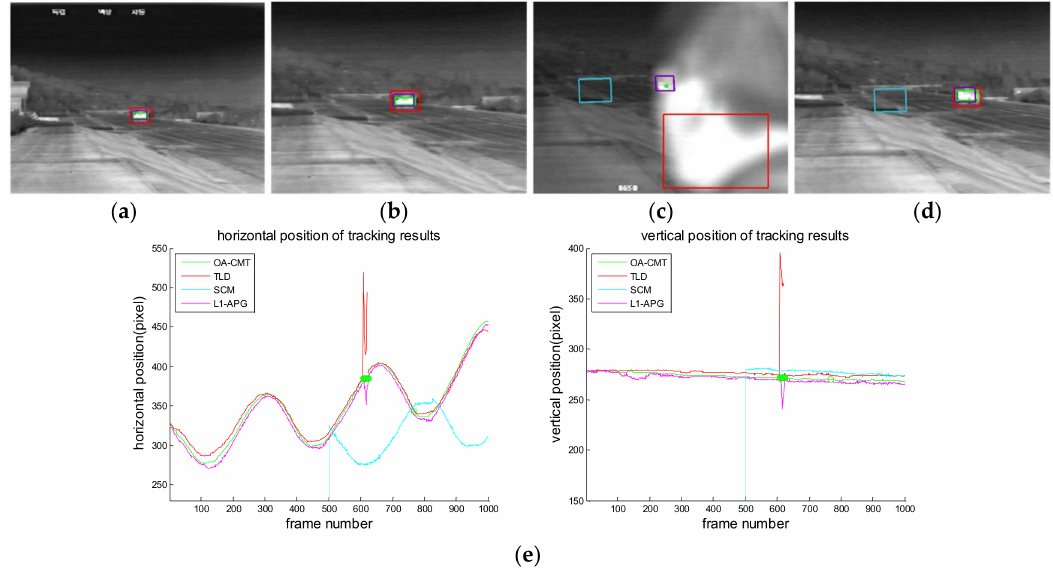
Figure 18. Computer simulation result of imagery ID 3. ( a ) Normal tracking status (original image); ( b ) magnifying interested area; ( c ) OA-CMT turns to memory tracking status when the tank is hidden by a human; ( d ) TLD, L1-APG and OA-CMT re-lock target successfully; ( e ) tracking trajectories of each trackers During blind time, tracking results of TLD are hopping because it tracks the human. SCM lost tracking with the changing shape of the target when tank turned its